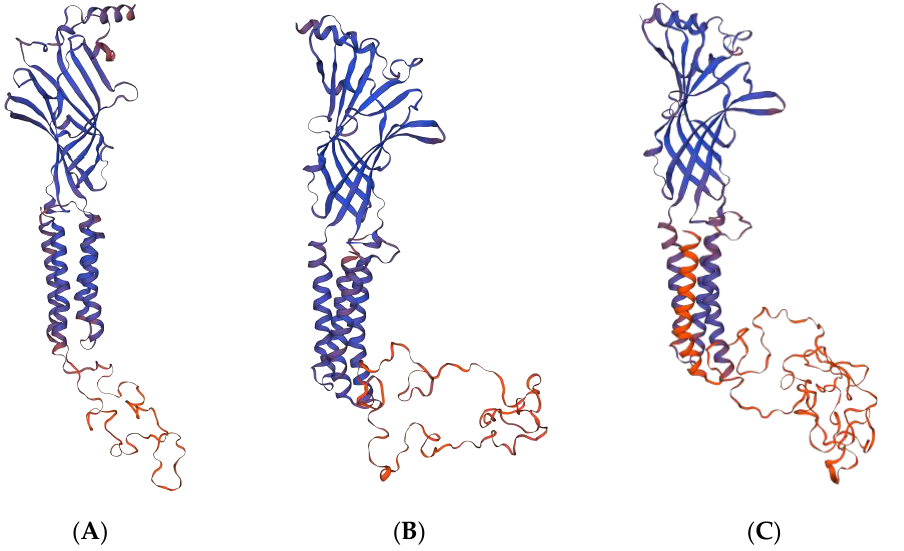
Figure 1. GABA receptor homology model using the Swiss model ( A ) GABA- α5, ( B ) GABA- β1, and ( C ) GABA- β2.